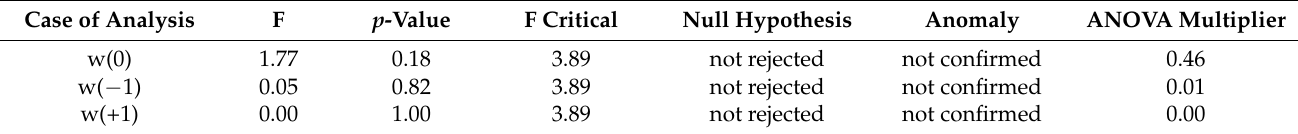
Table A9. Mann–Whitney test of the expiration price effects.